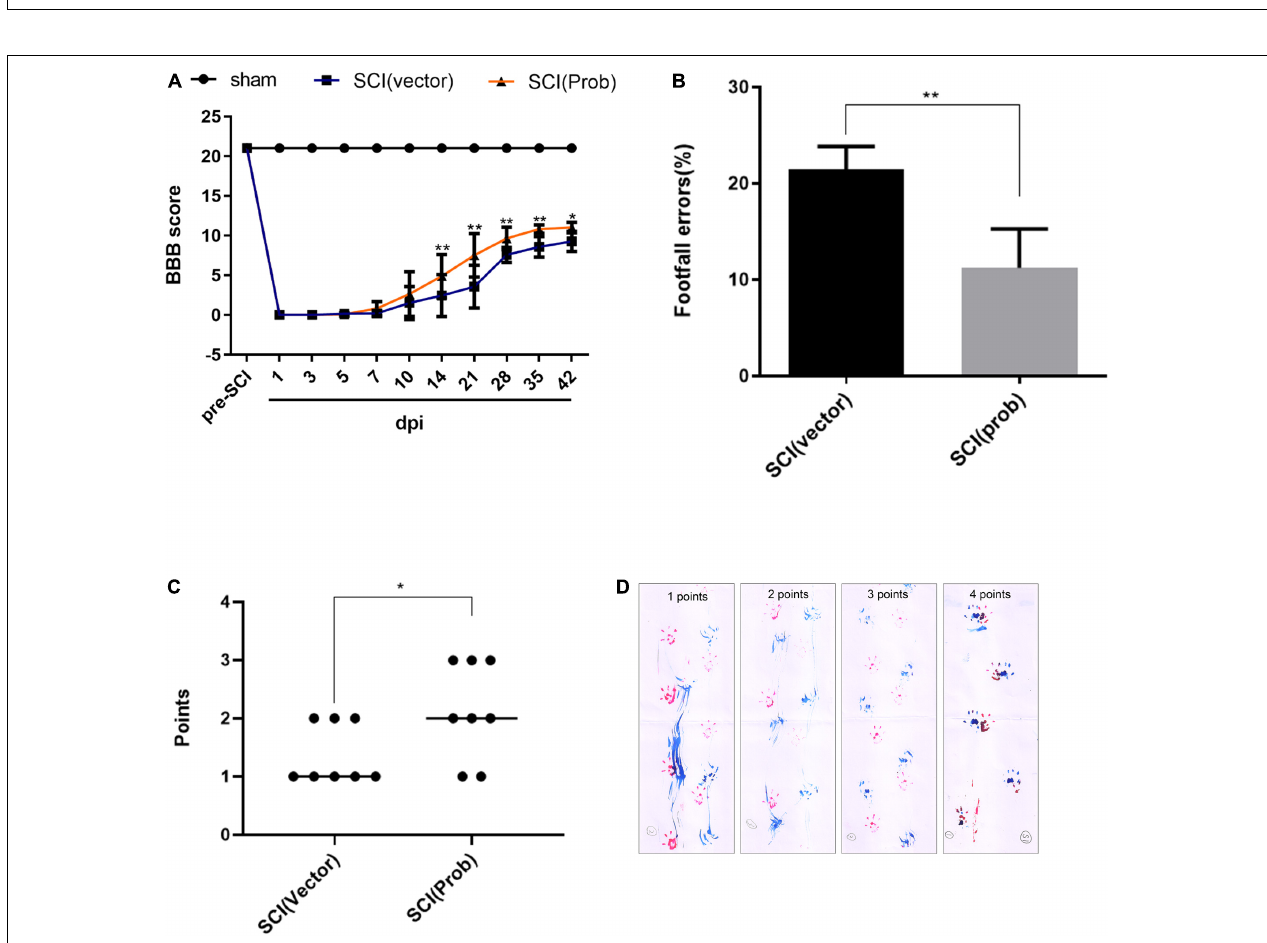
FIGURE 8 | Effects of Probenecid on behavior recovery following SCI. Motor function was evaluated by the BBB scoring, footprint analysis, and grid walk in the SCI (Prob) and SCI (vector) group. (A) The BBB scores of the three groups. (B) Grid walk test post SCI. (C) Footprint analysis post SCI. (D) Representative pictures of footprints of different points (* p < 0.05, ** p < 0.01 n = 8).